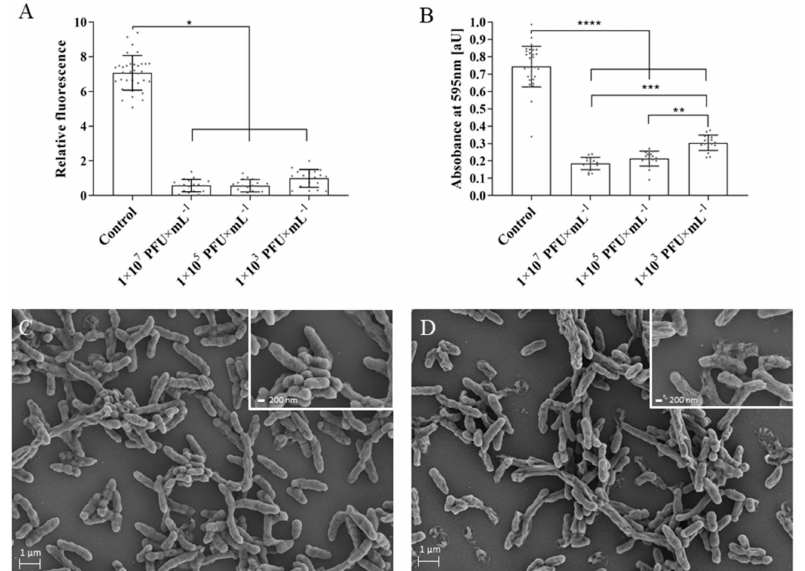
Figure 6. E ff ect of phage BB8 treatment on B. bronchisepica biofilm. Decrease of ( A ) viability and ( B